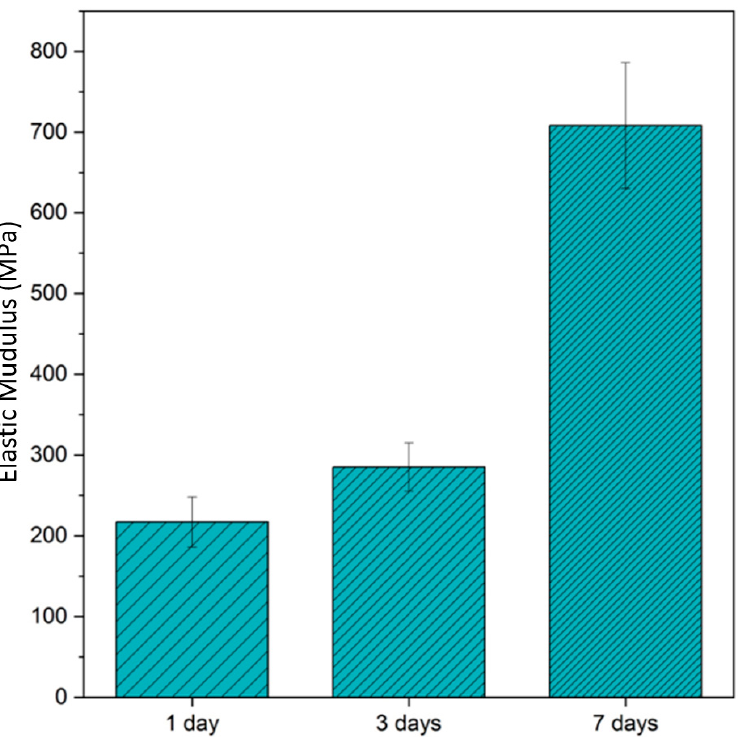
Figure 4. Elastic modulus from AFM force–distance curves of P(3 HB-co-88% 3 HV) one, three, and seven days after the deposition of the thin film.